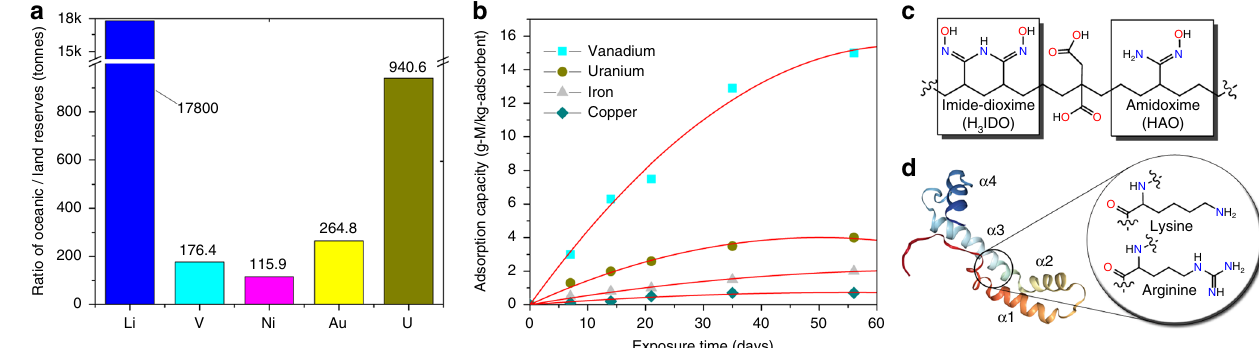
Fig. 1 Critical metals in seawater and extraction systems. a Estimated ratio of the amounts of selected critical metals in the oceans to the terrestrial reserves 49 . b Adsorption kinetics of vanadium, uranium, iron, and copper by typical polyamidoxime adsorbents after 56 days of contact with seawater (Sequim Bay, USA) in fl ow-through columns 7 . c Schematic depiction of a small subsection of the polyamidoxime fi ber. d Cartoon representation of vanabin2 with the highlighted amino acid residues participating in vanadium binding